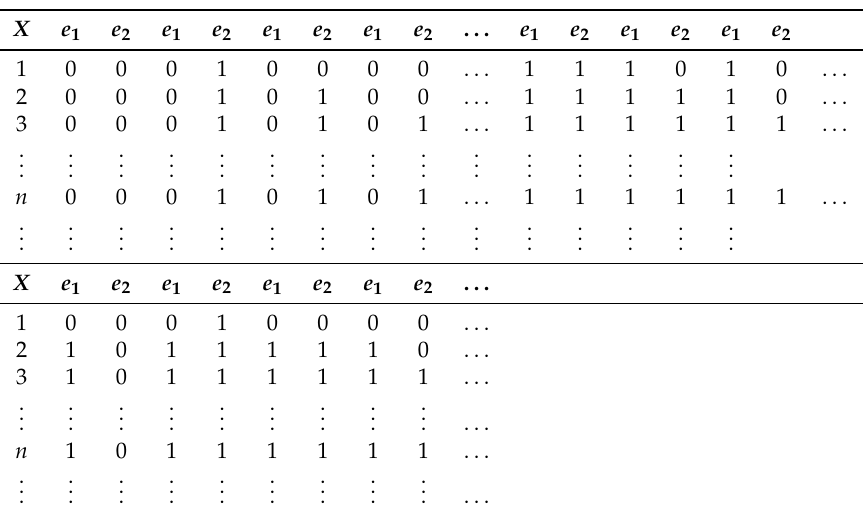
Table 2. Tabular representations of the countably many members of the soft open base B ( β 1 ) for a soft topology on X = N in Example 3: A